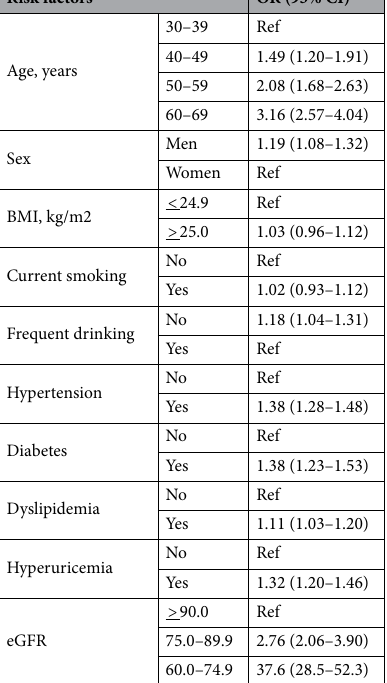
Table 5. Mean odds ratios and 95% confidence intervals of multivariable logistic regressin analysis from bootstrap resample method. The odds ratios and 95% confidence intervals of 5-year incidence of CKD for each risk factors using logistic regression analysis with 2500 bootstrap resampling. In multivariable model, the odds ratios were adjusted for the following variables: age categories, sex, body mass index categories, current smoking, frequent drinking, hypertension, diabetes, dyslipidemia, hyperuricemia, and eGFR categories. BMI body mass index, OR odds ratio, CI confidence